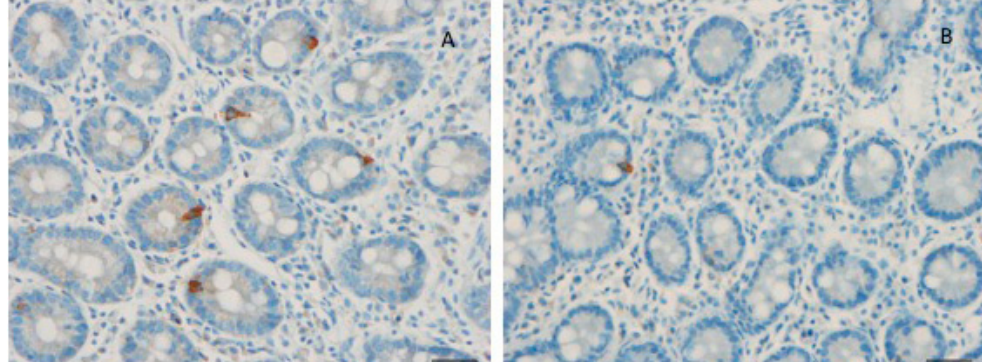
Figure 3. Duodenal cholecystokinin (CCK) cells of a healthy subject ( A ) and of a patient with irritable bowel syndrome (IBS) ( B ). Patients with IBS have a low density of CCK cells.